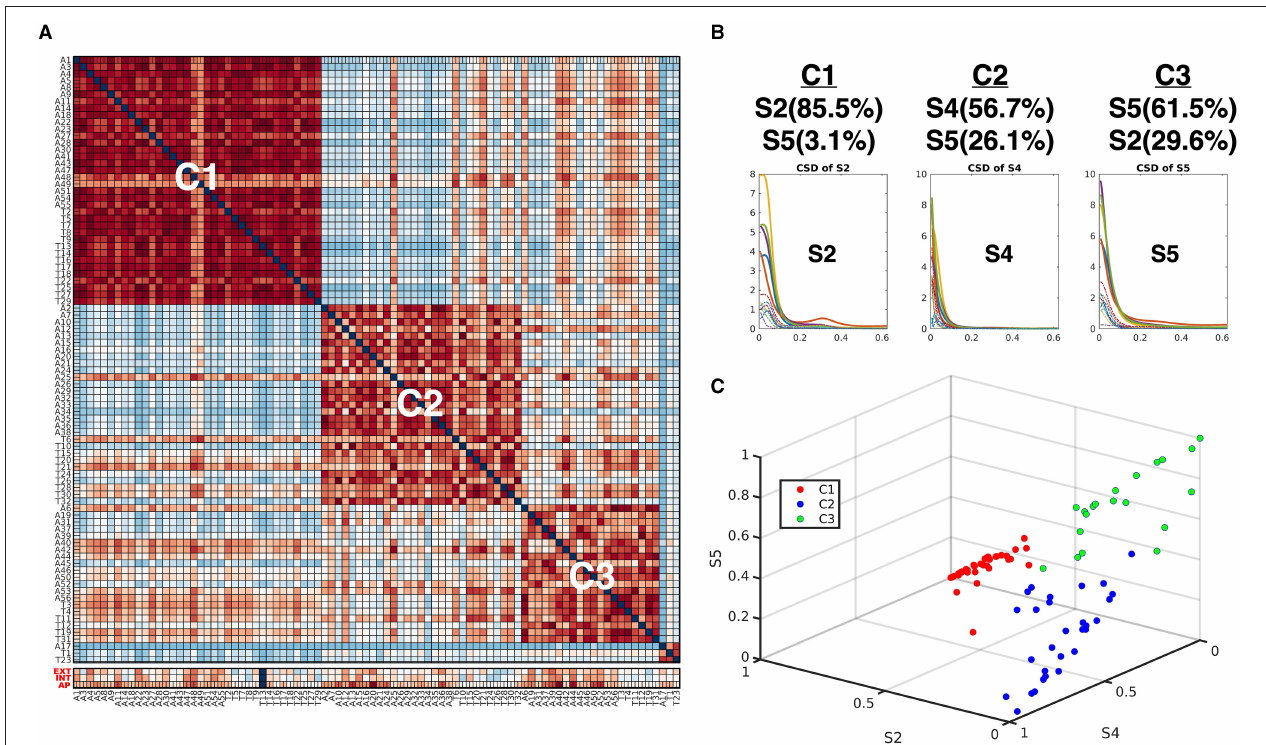
FIGURE 6 | (A) Subtypes of individuals according to the similarity of the occupation indices of an individual of the five connectivity states. The similarity matrix of the occupation indices of the states across individuals was sorted using modularity optimization. The children with ADHD-C were labeled with “A,” and the TDC were labeled with “T.” The last three lows (red labels) indicate CBCL-EXT, CBCL-INT, and CBCL-AP. (B) The occupation indices of the three major CSD for each subtype C1, C2, and C3 are displayed. (C) The occupation indices of the three dominant states of individuals (S2, S4, and S5) were plotted with colors (subtype C1 with red, subtype C2 with blue, and subtype C3 with